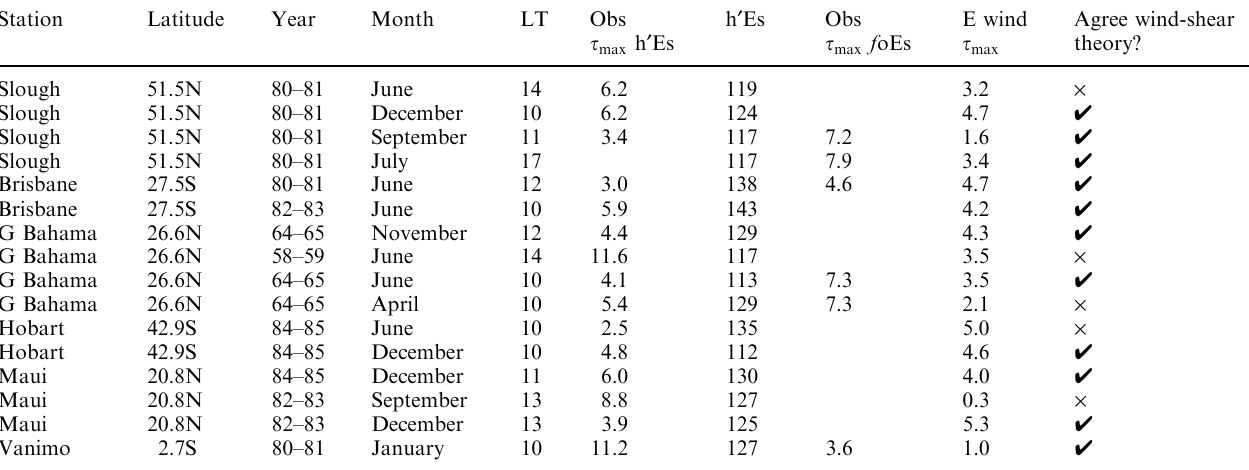
Table 1. Comparison of lunar Es phases with those determined from the GSWM model Station Latitude